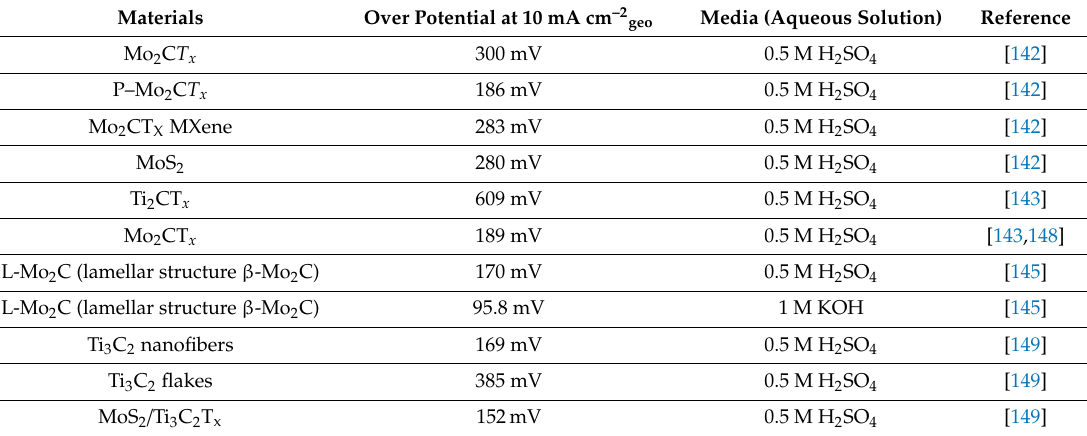
Table 6. HER activity of di ff erent 2D nanomaterials with di ff erent